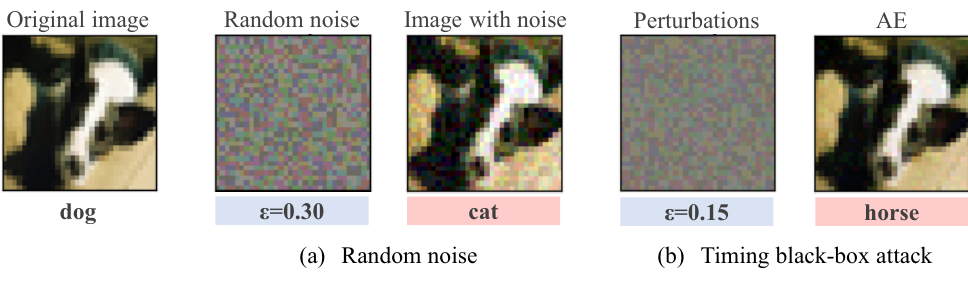
Figure 14: AEs of proposed attack and random noise against CNN model on MCU. Perturbation bound, ε , and misclassification labels are shown in the